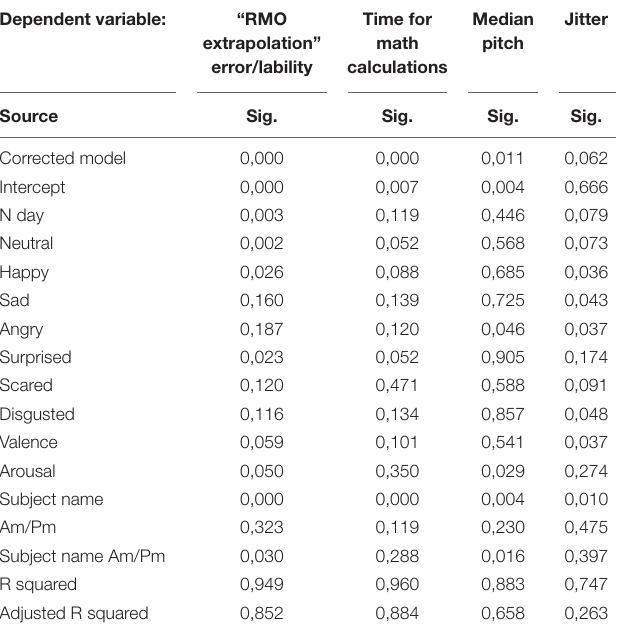
TABLE 2 | Tests of between-subjects effects with basic emotions and days covariates. Dependent variable: “RMO